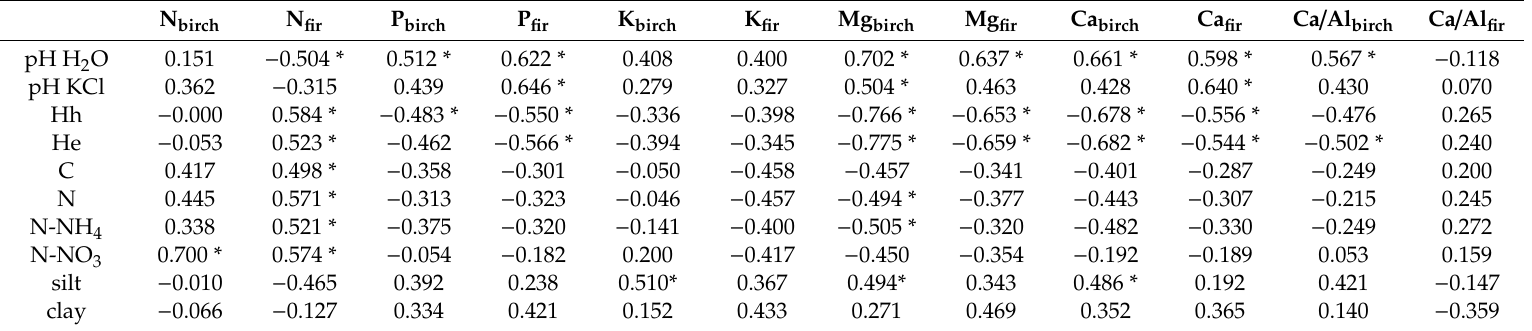
Table 8. Correlations between the content of selected macroelements in the leaves and needles of seedlings and soil